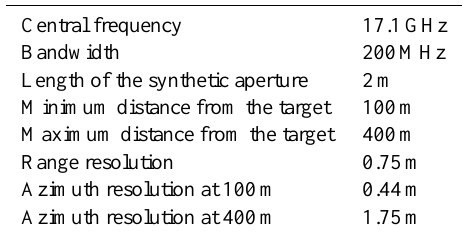
Table 1. Parameters used during the Santa Trada monitoring cam-